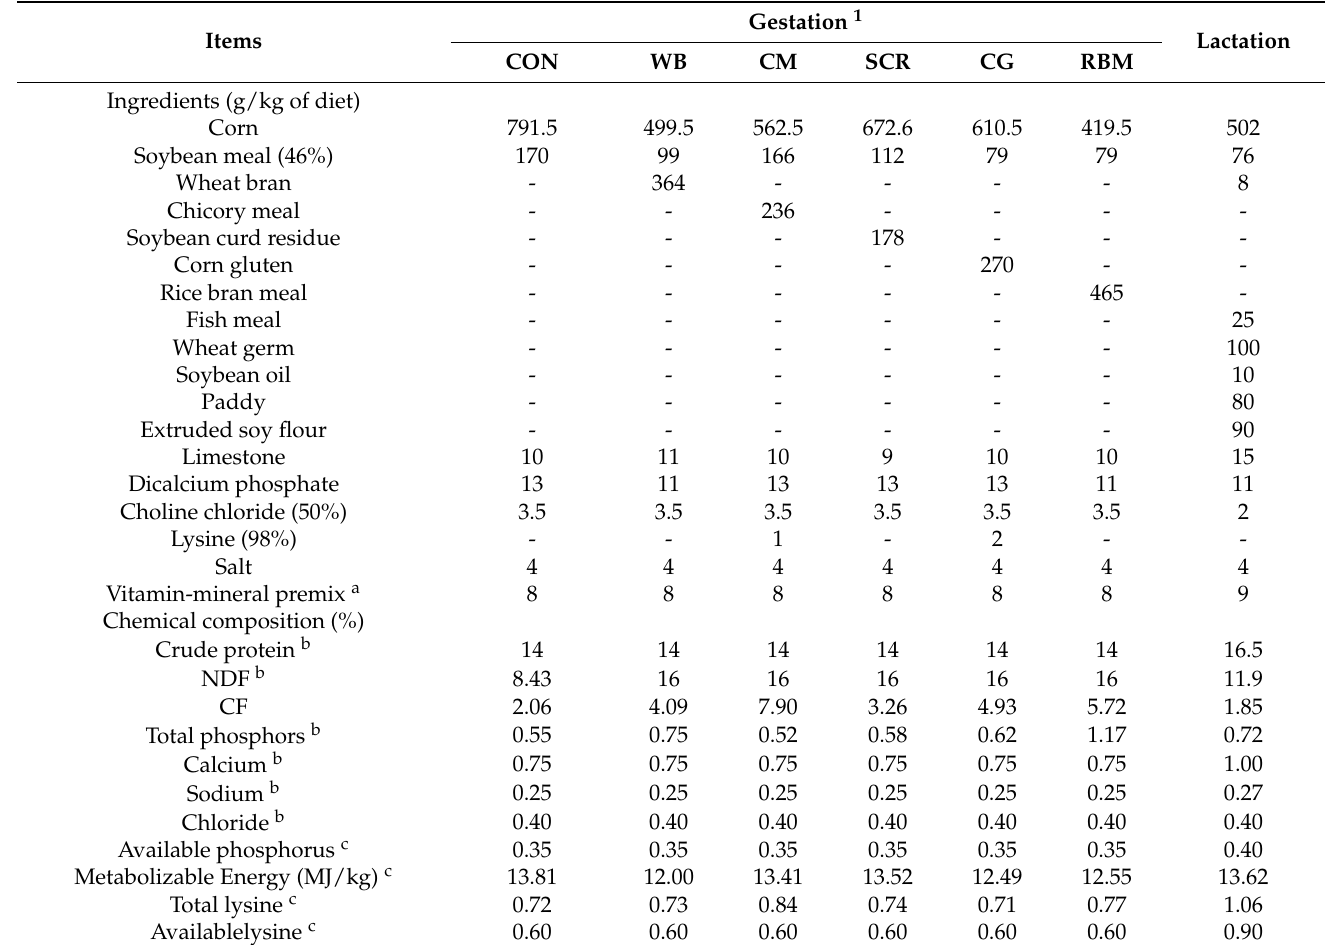
Table 1. Ingredients and nutrient levels in the gestation and lactation